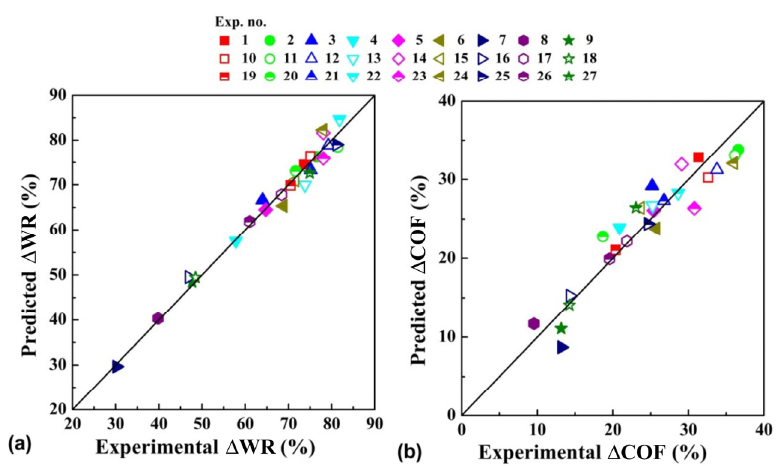
Fig. 13 Experimental vs. predicted values of (a) ∆ WR and (b) ∆